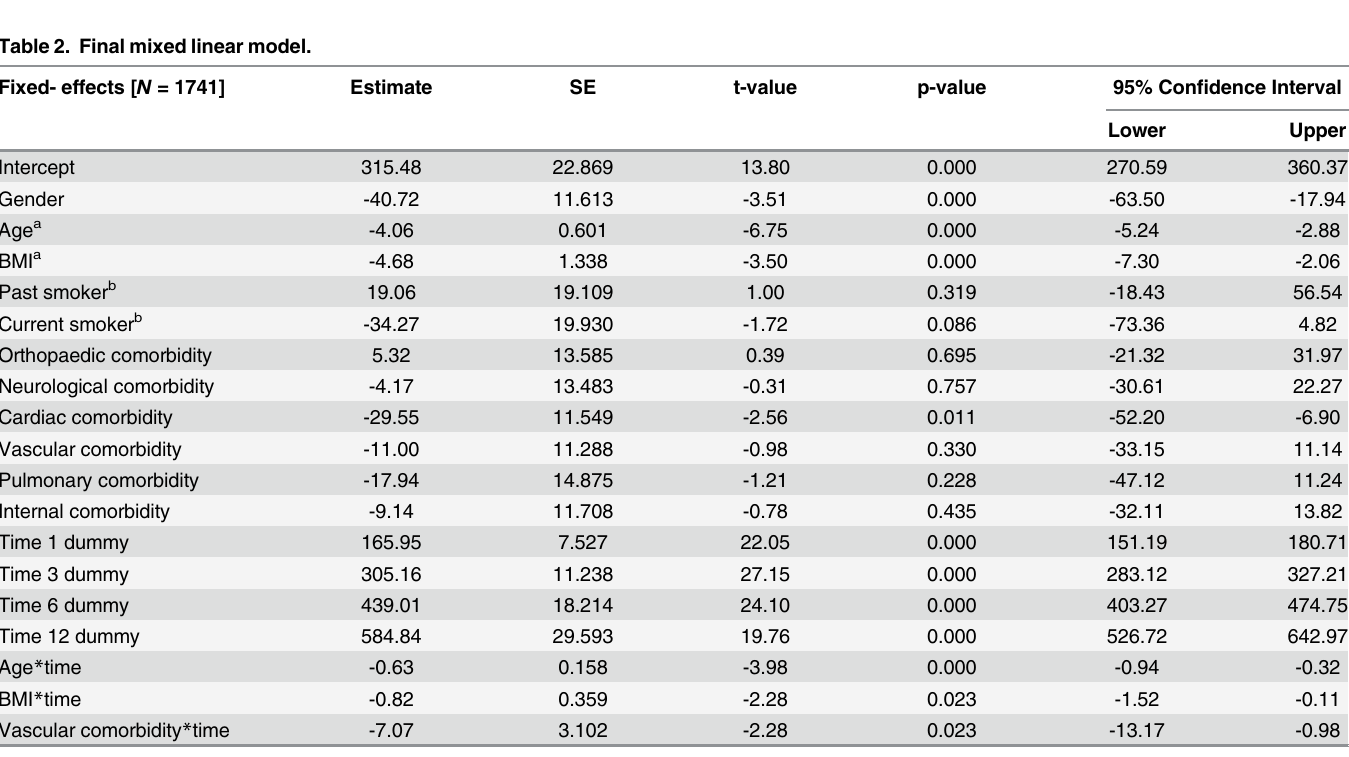
Table 2. Final mixed linear